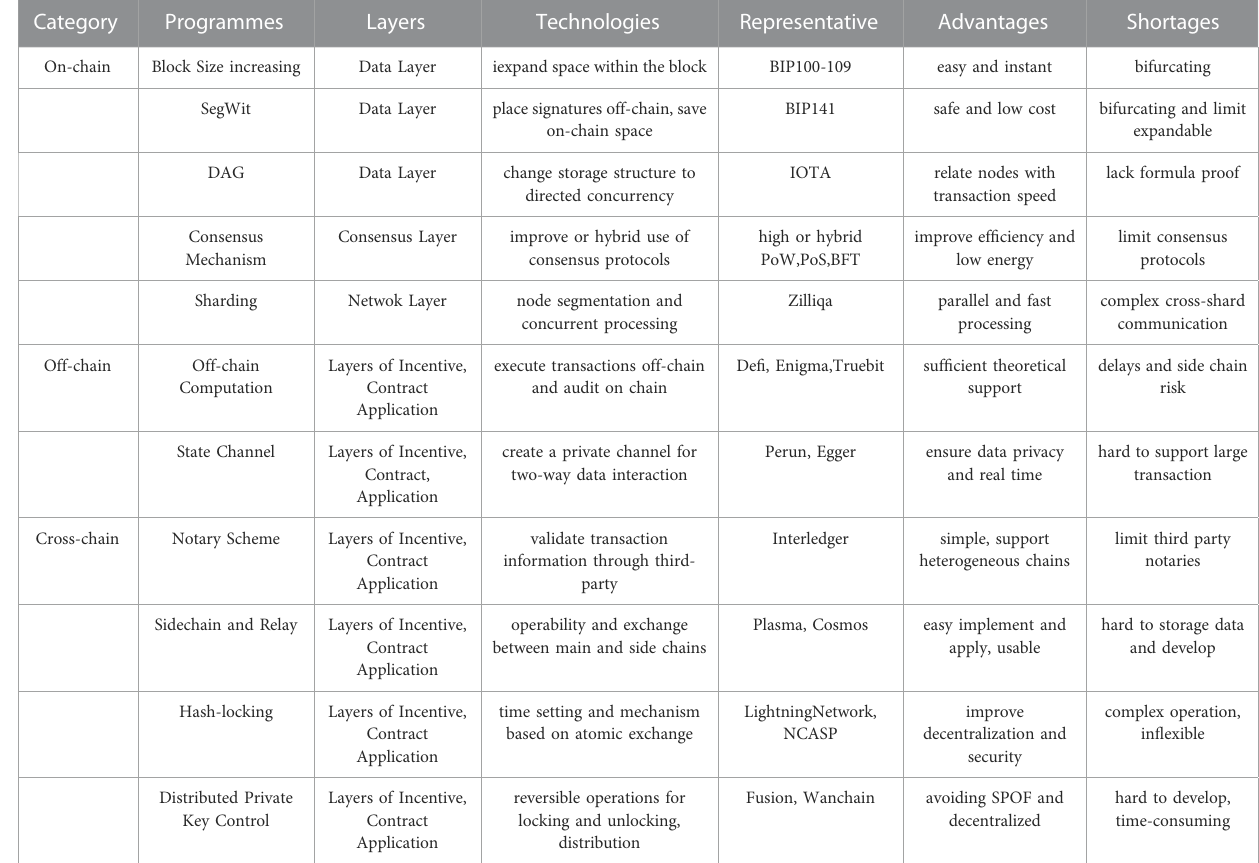
TABLE 2 Summary of high-performance data interaction technologies.